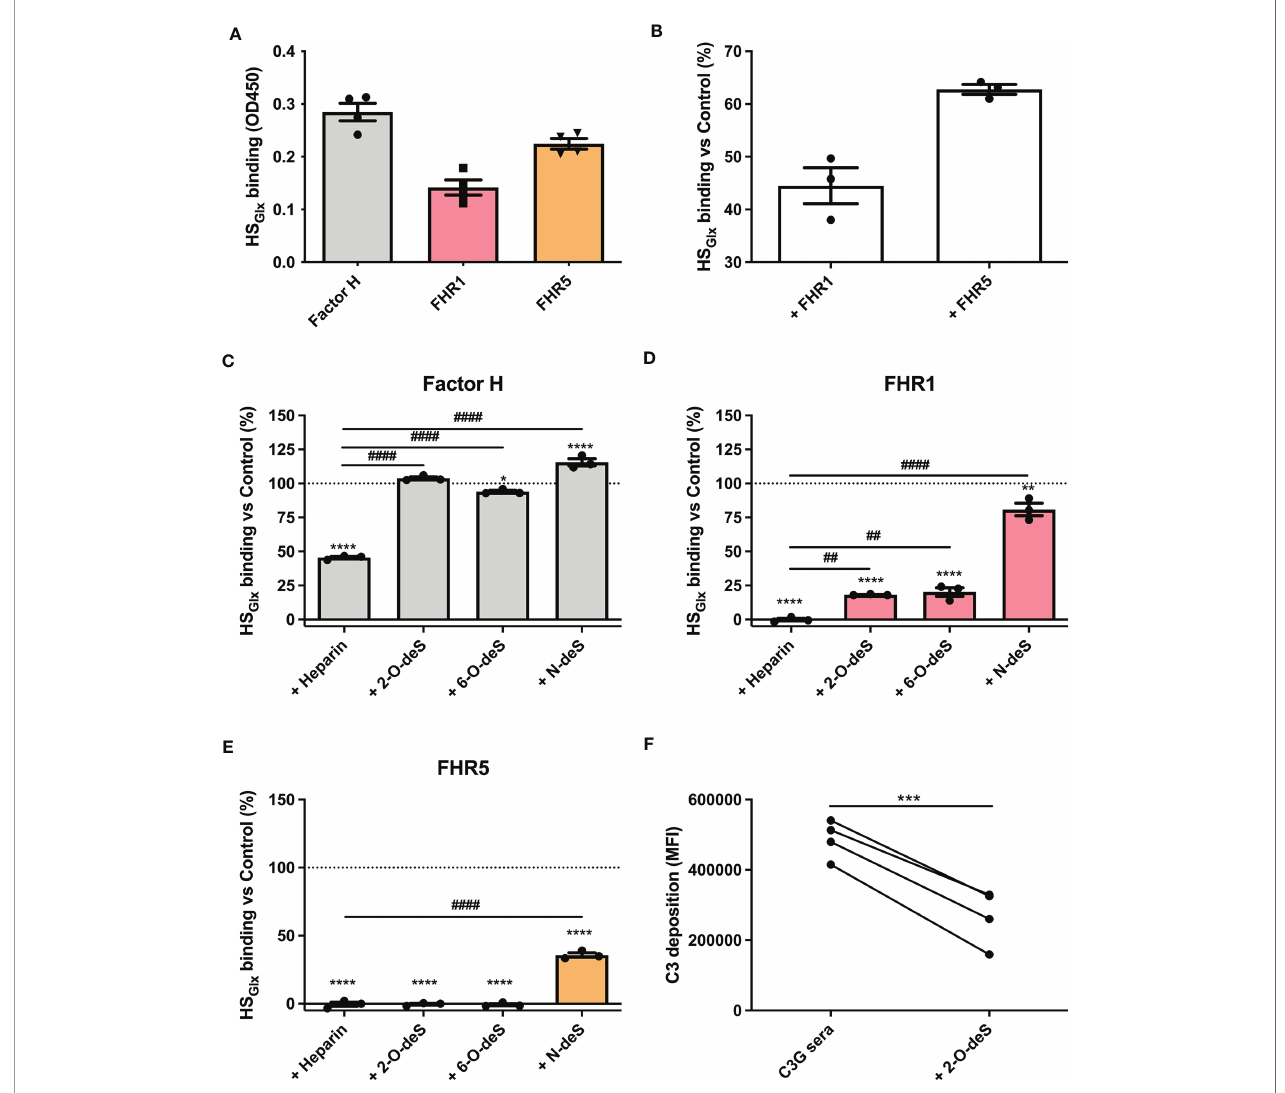
FIGURE 3 | O-desulfated heparins reduce FHR1 and FHR5 binding to puri fi ed glomerular endothelial glycocalyx-derived heparan sulfate (HS), without affecting FH binding. HS was puri fi ed from isolated glycocalyx from conditionally immortalized glomerular endothelial cells (HS Glx ) and immobilized on microtiter plates. Binding of factor H (FH) and factor H-related proteins (FHRs) was measured using ELISA (n=4) (A) . For competition assays, HS Glx was incubated with FHR1 or FHR5 before binding of FH was determined (n=3) (B) . The contribution of speci fi c sulfate modi fi cations to HS Glx binding of FH (n=3) (C) , FHR1 (n=3) (D) and FHR5 (n=3) (E) was evaluated by preincubating proteins with buffer (Control), heparin or 2-O-, 6-O- and N-desulfated (deS) heparin before addition to microtiter plates. To investigate potential therapeutic effects of 2-O-desulfated heparin in context of C3G patient sera (402H/H haplotype group with >1.5x increased C3 deposition compared to NHS), sera were supplemented with 50 µg/ml 2-O-desulfated heparin before addition to the cells (n=4) (F) . (*p < 0.05, **p < 0.01, ****p < 0.0001 vs Control; ## p < 0.01, #### p < 0.0001 vs Heparin; ***p<0.001 vs C3G